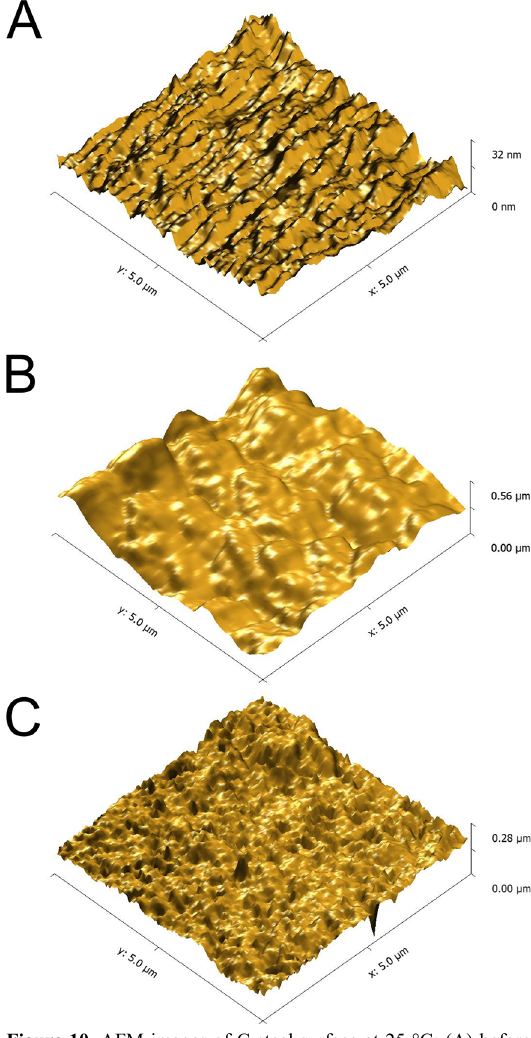
Figure 10. AFM images of C-steel surface at 25 °C: (A) before immersion; (B) after 2.0 hr of immersion in 1.0 mol∙L -1 HCl; (C)